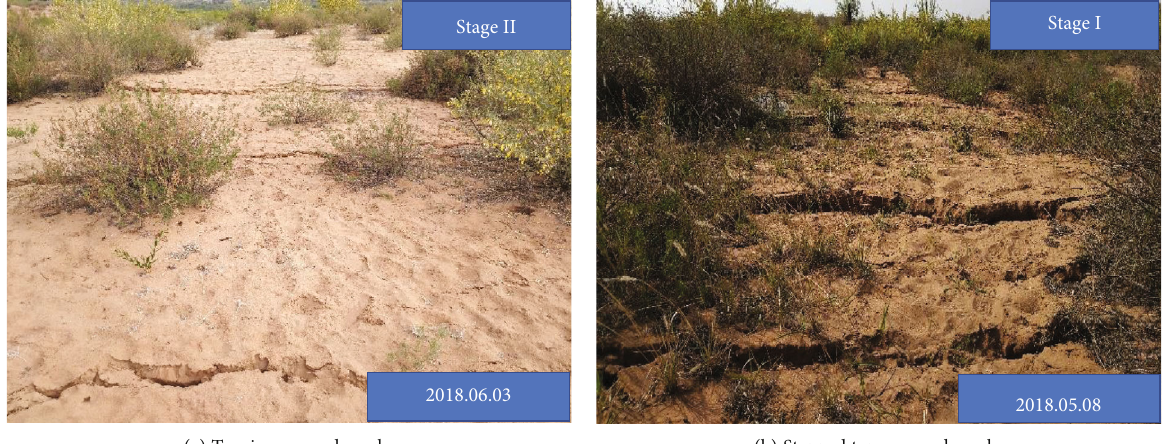
Figure 13: Dynamic ground cracks in the middle of panel 12401.